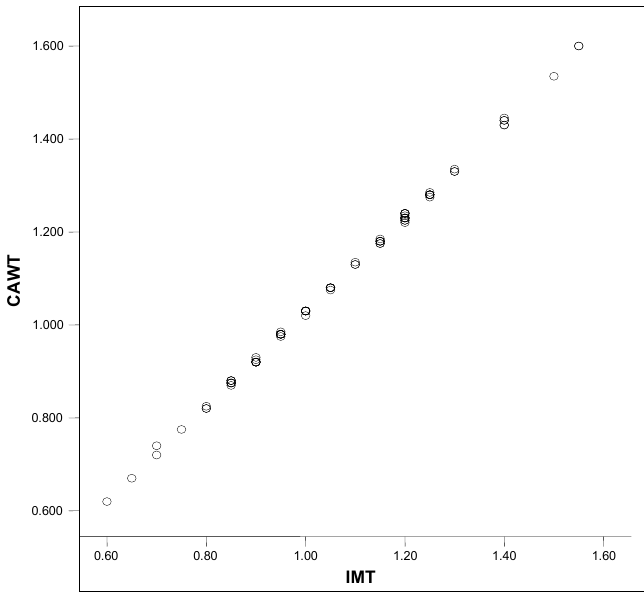
FIGURE 4. Relationship between CAWT and IMT. X axis: IMT values measured by US; Y axis: CT-CAWT values for the same